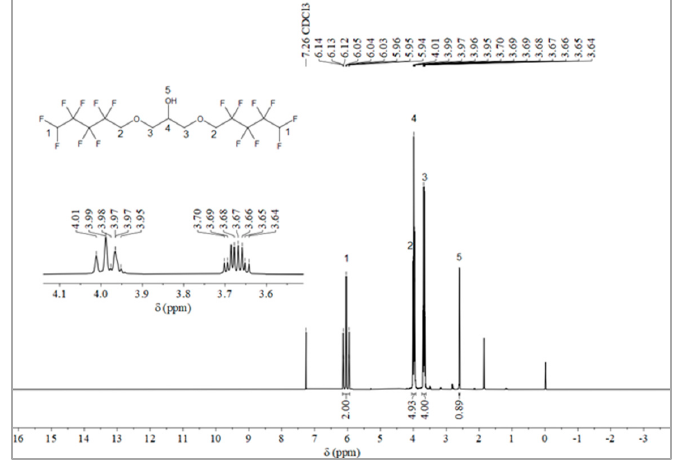
Figure 2. 1 H NMR spectra of OFPA.